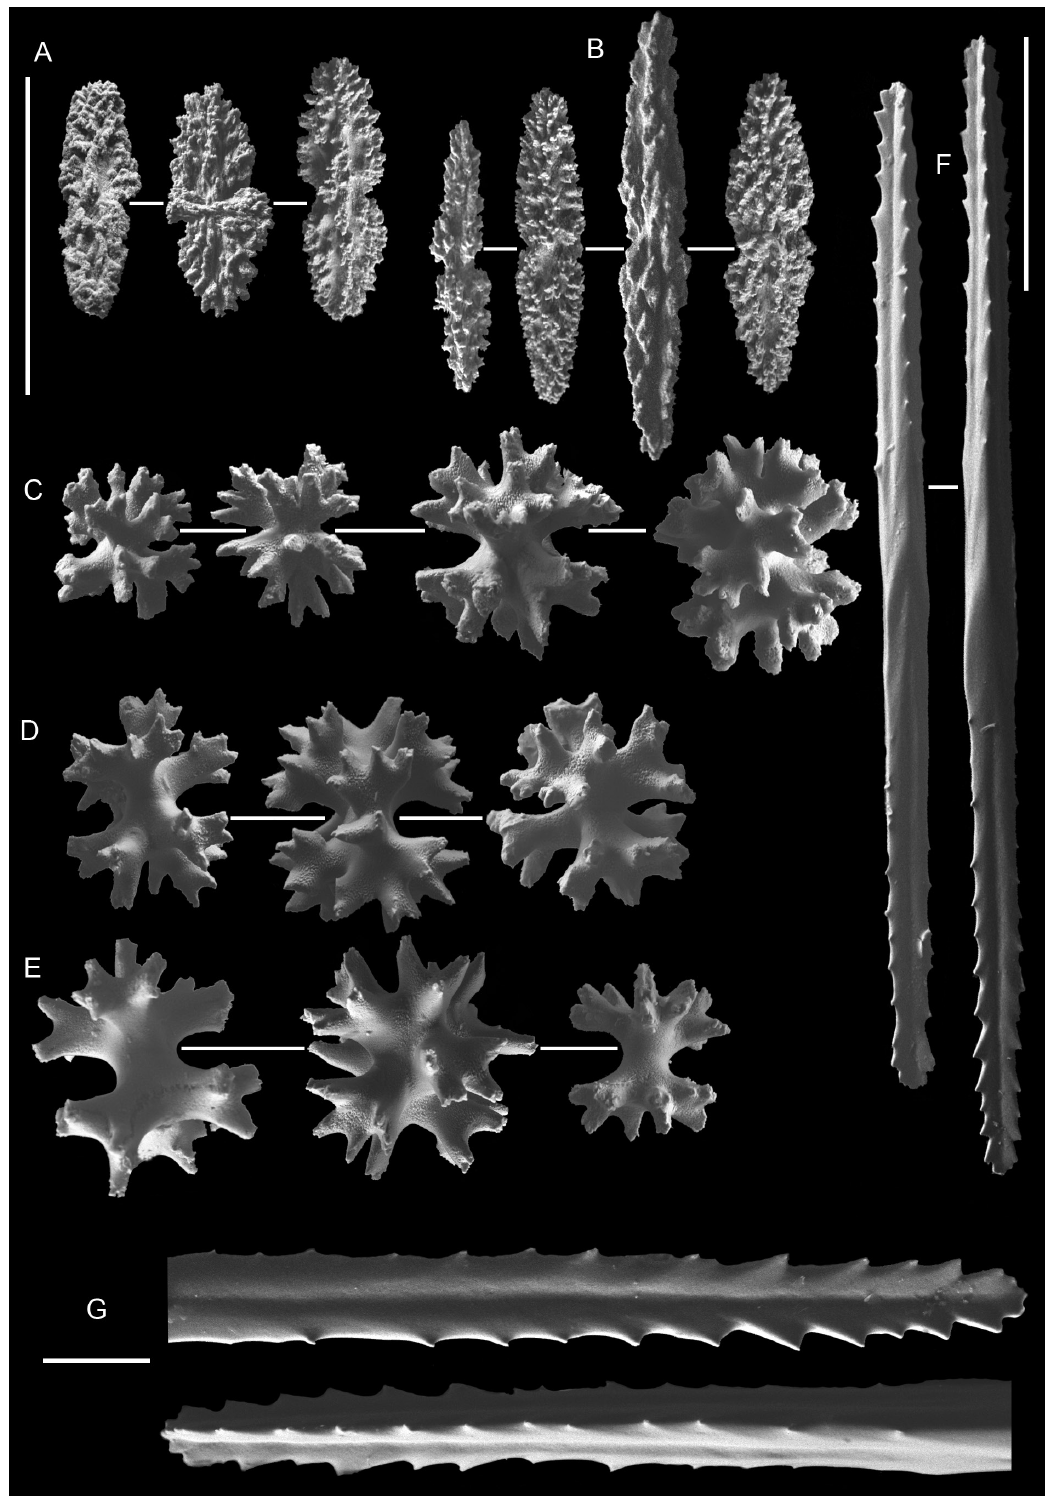
Fig. 5. Heteropolypus annae sp. nov., paratype (MIMB 42494); sclerites from the autozooid pharynx, anthocodiae, and the colony body. A . Waisted plates. B . Waisted rods. C . Anthocodiae capstans. D . Capitulum surface capstans. E . Stalk surface capstans. F . Needles. G . Ends of the same needle. Scale bars: A–F = 0.1 mm; G = 0.02